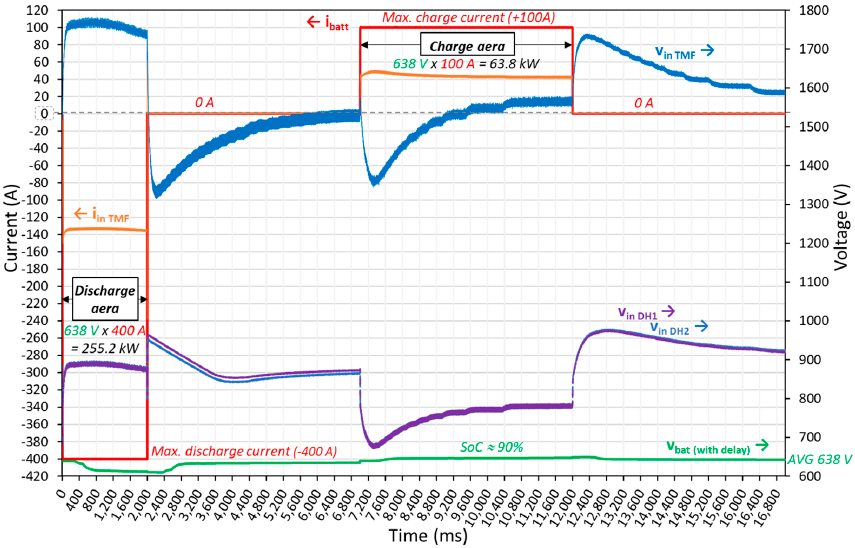
Figure 17. Typical battery charge/discharge cycle: platform results with the 300 kW/147 kWh elementary block prototype.